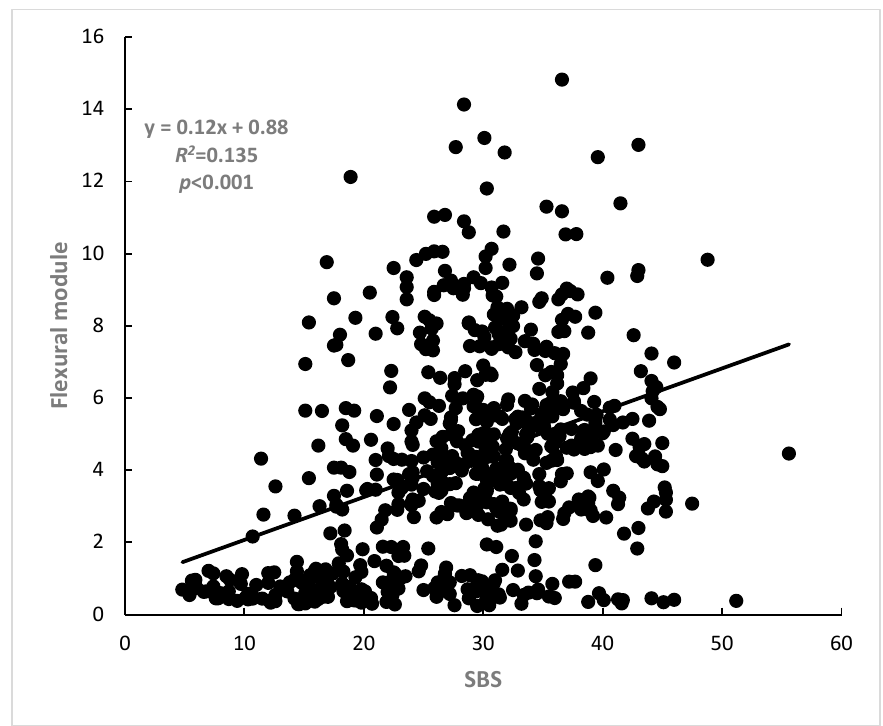
Figure 2. Correlation between flexural modulus of elasticity and shear bond strength to IPS e.max CAD ( R 2 = 0.14, p < 0.001).